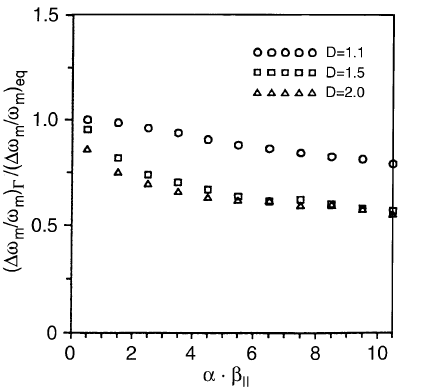
Fig. 6. Relationship between relative frequency shift of the VLF emission maximum at the output of the amplification region and the relative frequency shift of the maximum growth rate in the equato- rial plane as a function of (cid:97)(cid:98)